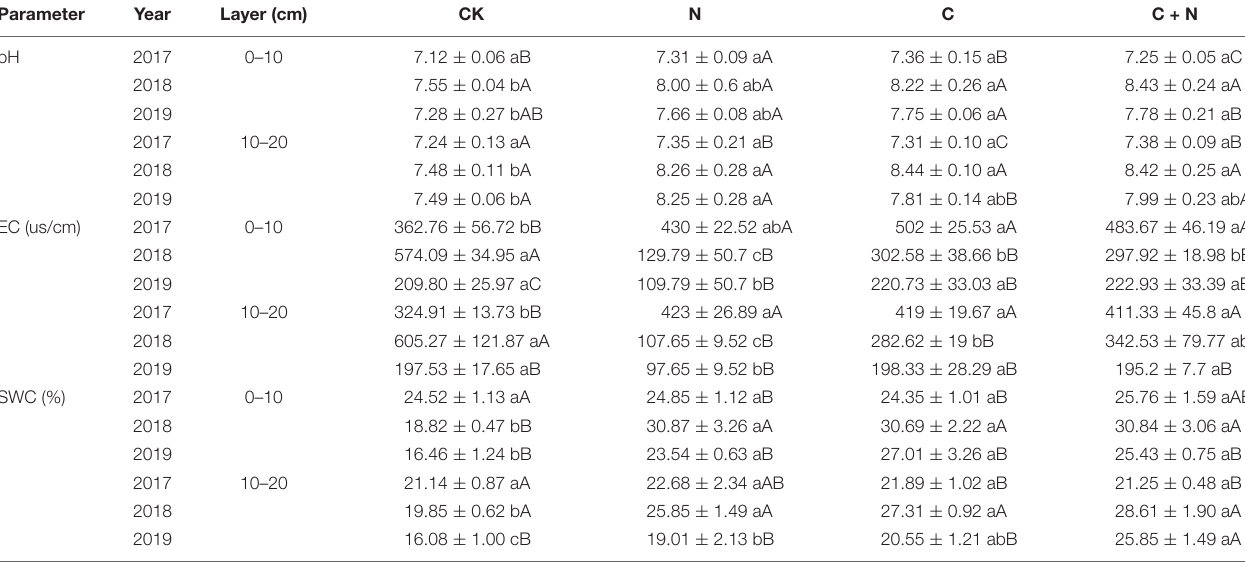
TABLE 1 | Variation of soil pH, electrical conductivity (EC), and soil water content (SWC) in the 0–20 cm soil layers under different treatments in 2017, 2018, and 2019. Parameter Year Layer (cm) CK N C C +